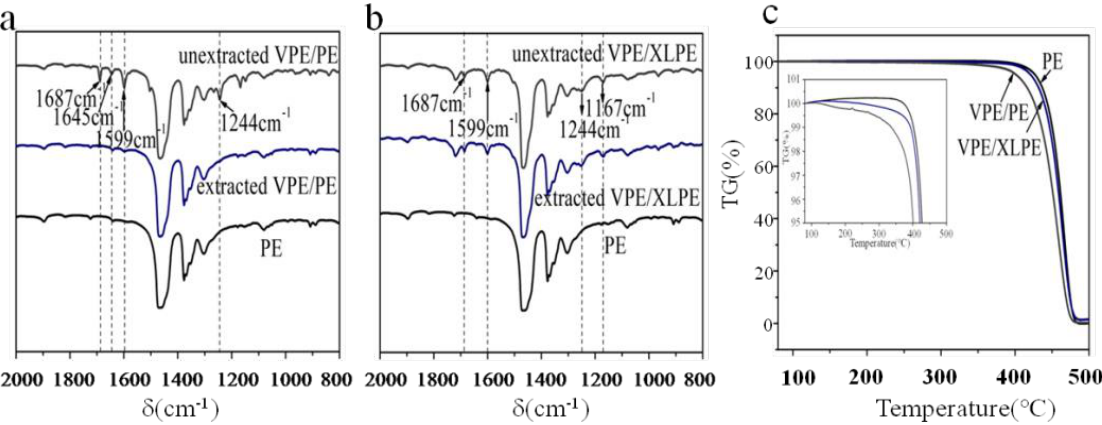
Figure 2. TGA and FTIR analysis. ( a ) infrared spectrum pre-and post-extraction of VPE/PE; ( b ) infrared spectrum pre-and post-extraction of graft VPE/XLPE; ( c ) TGA of PE, VPE/PE, graft VPE/XLPE.